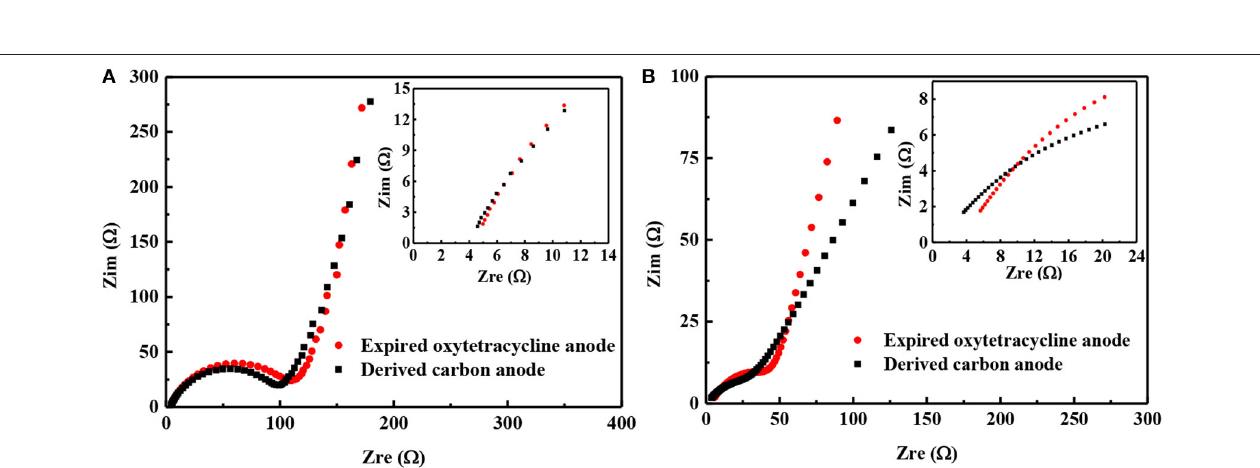
Frontiers in Materials |